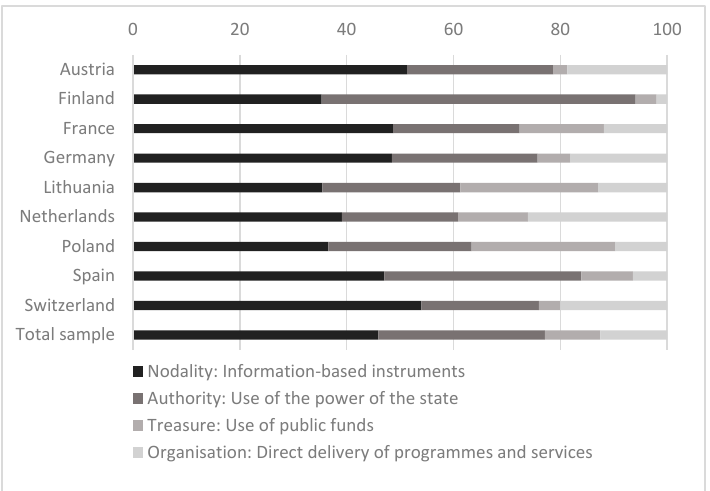
Figure 2. Adaptation policy instruments grouped according to NATO framework (%).